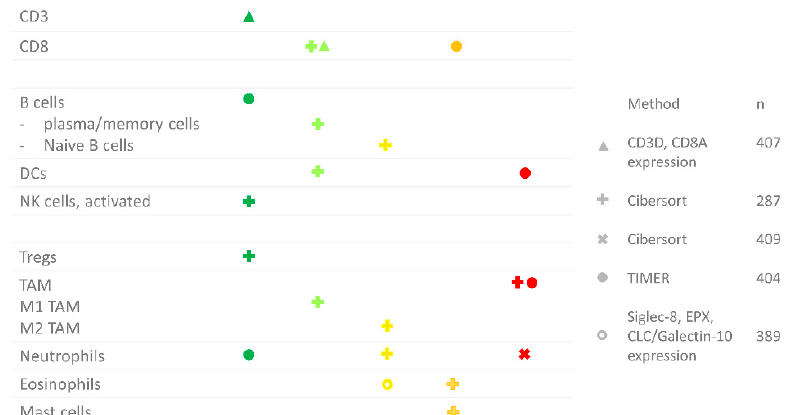
Figure 3. Overview of RNA sequencing studies in bladder cancer per immune cell type. The color (and position) indicate whether there was a positive or negative correlation. Dark green: significant positive correlation; light green: trend towards a positive correlation; yellow: no trend; orange: trend towards a negative correlation; red: negative correlation. The shape indicates the study where the data was derived from: ∆ [13], + [24], x [51], • [12], o [52].